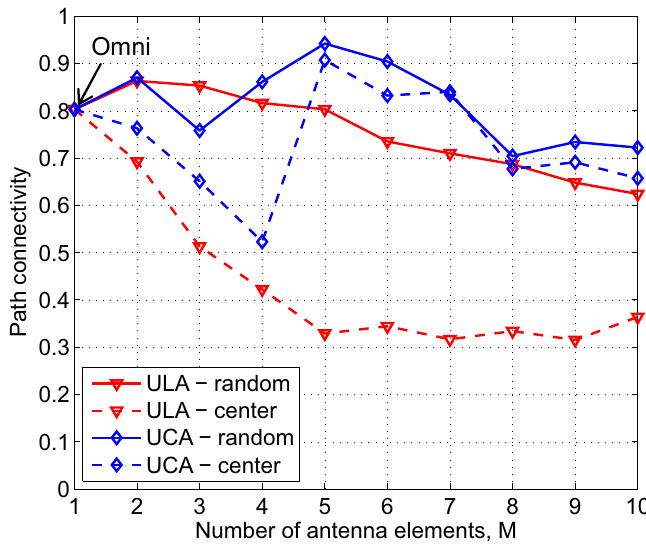
Figure 9. Path connectivity corresponding to different kinds of antennas and beamforming schemes as a function of the number of antenna elements; a = 500 m, N S = 200, N P = 3, λ P = 0.1, α = 3, γ th = 50